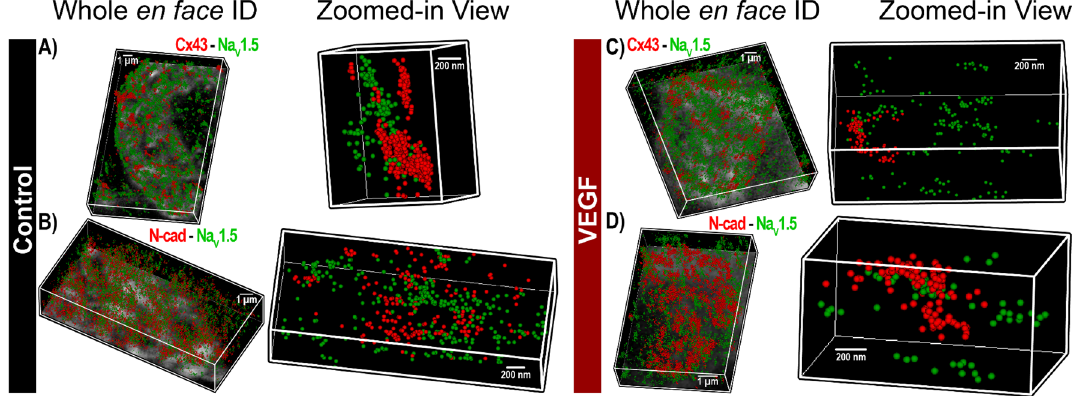
Figure 7. STORM imaging of atrial IDs—Na V 1.5. Representative 3D STORM images of en face IDs immunolabeled for Na V 1.5 along with Cx43 and N-cad from ( A, B ) control and ( C, D ) VEGF-treated murine atria. STORM data are rendered as point clouds with each localized molecule represented as a 50 nm sphere. Although 20 nm resolution was achieved, the 50 nm size was chosen for rendering to guarantee visibility in print.